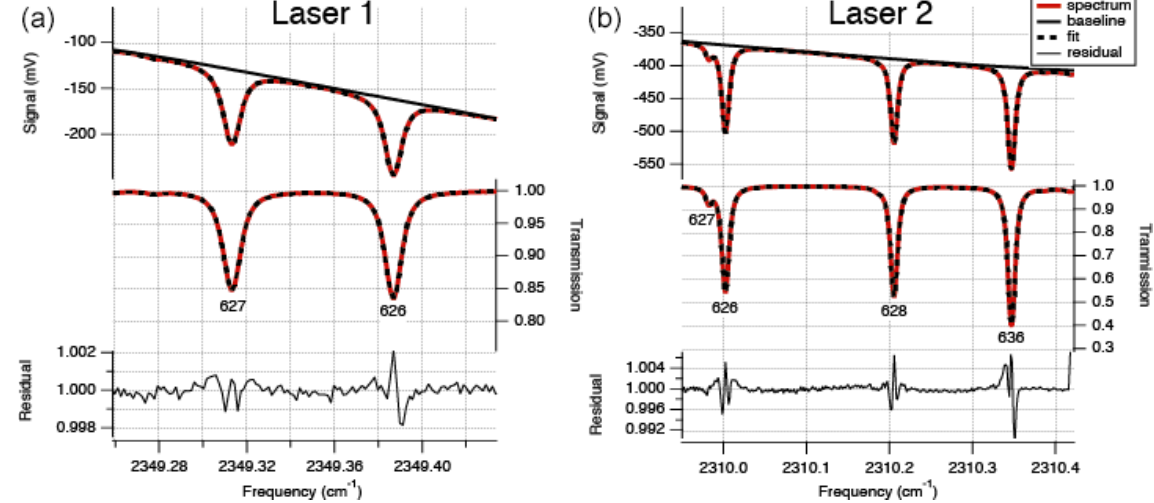
Figure 2. Typical absorption spectrum, transmission spectrum and residual for laser 1 (a) for measurement of 627 and 626 and laser 2 (b) for measurement of 626, 628 and 636. The residuals show systematic deviations at the line positions. These deviations are primarily due to the use of the Voigt line shape function in the spectral fitting model, rather than a more complex line shape function such as Hartmann–Tran. Careful analysis has shown that the use of the more convenient Voigt line shape function does not add noise, drift or calibration error as implemented in the isotope analyzer.